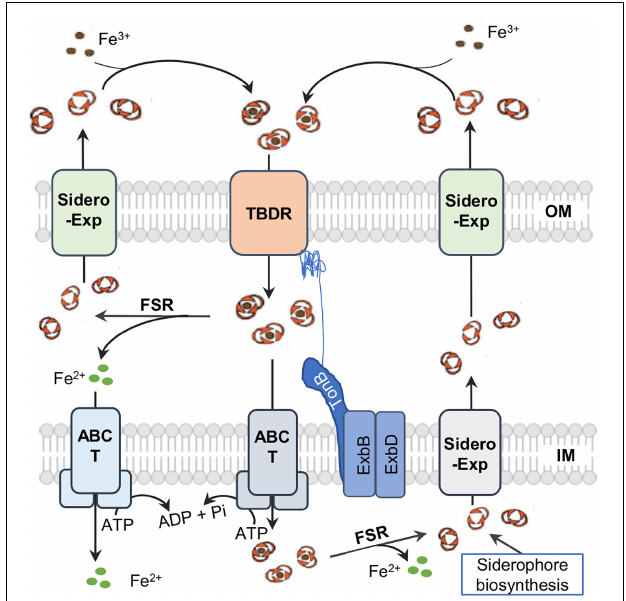
FIGURE 2 | A simplified view of siderophore-meidated iron transport in Gram-negative bacteria. Siderophores are synthesized in the cytoplasm and exported by diverse exporters (Exp) on the IM (inner membrane) and OM (outer membrane). Ferrisiderophores are imported into the periplasm by TonB-dependent receptor (TBDR) on the OM. In most cases, ferrisiderophores are subsequently transported by transporters, mostly ABC transporters (T), into the cytoplasm, where reduction takes place by a specific ferrisiderophore reductase (FSR) to release iron in the ferrous form. In some rare cases, ferrisiderophores in the periplasm are directly reduced to release ferrous iron and siderophore molecules, which then are transported across the IM by a specific ABC transporter and across the OM by siderophore exporter for reuse